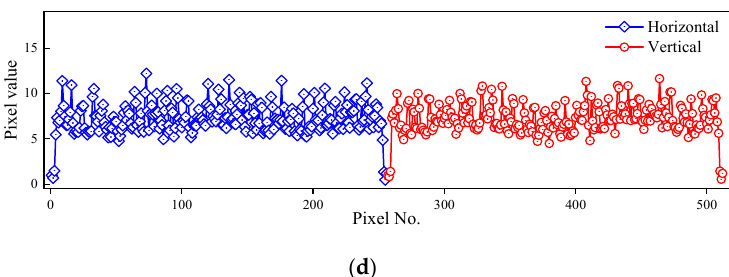
Figure 7. Integral projection results of images using LoG: ( a ) Longitudinal crack; ( b ) transverse crack; ( c ) oblique crack; ( d ) without crack.